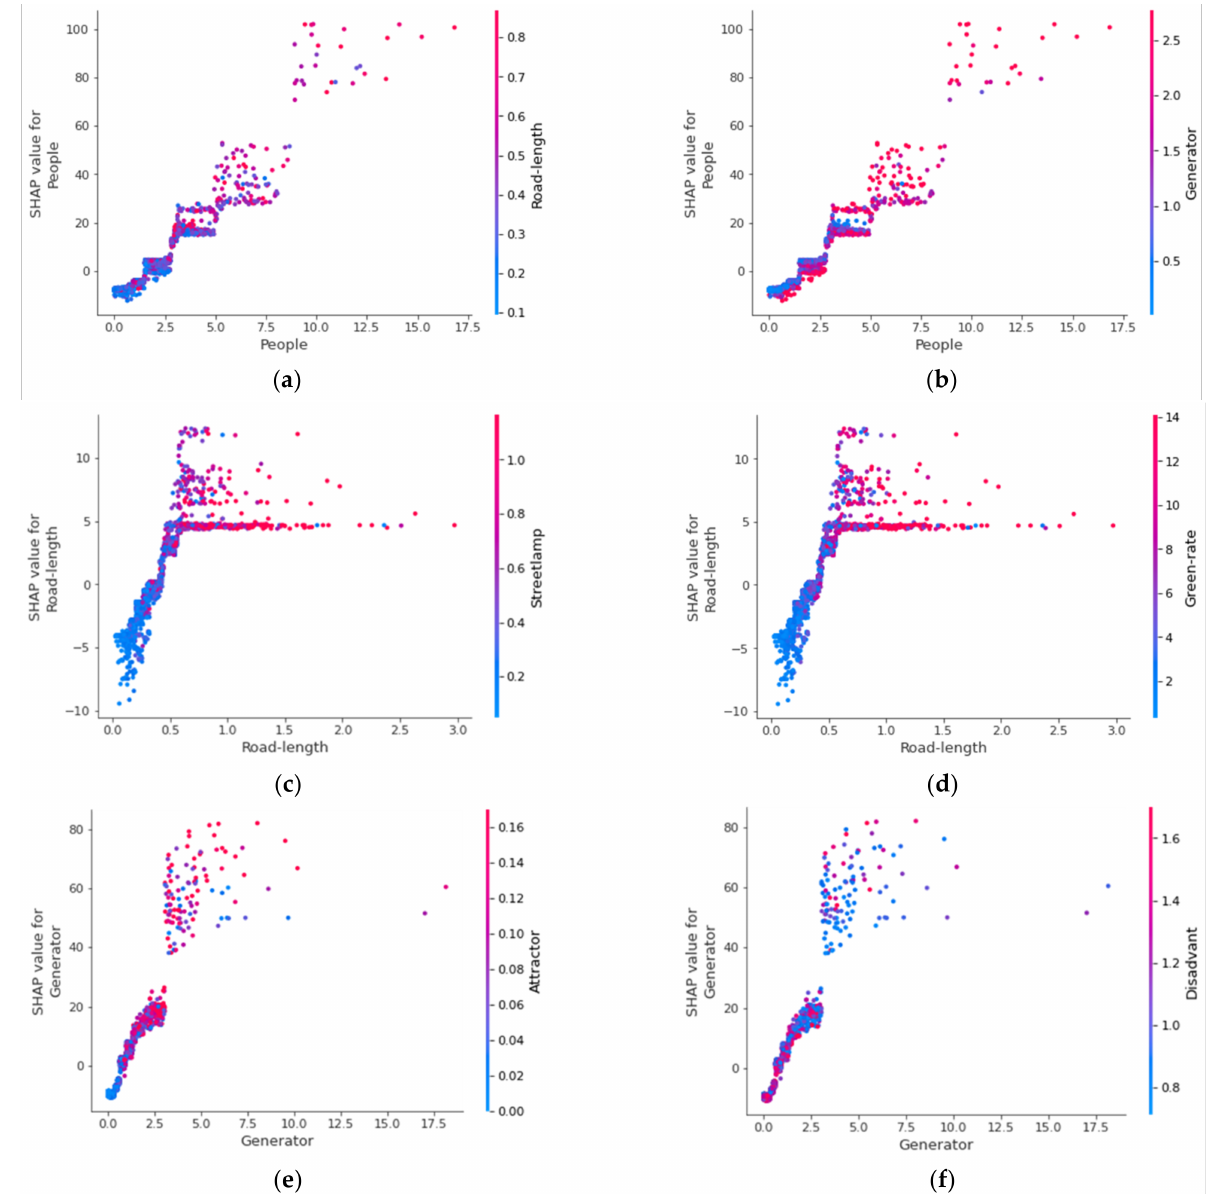
Figure 10. The interaction effect between different variables. ( a ) the number of people on the street and the length of the street segment, ( b ) the number of people on the street and crime generators, ( c ) the length of the street segment and the number of street lights, ( d ) the length of the street segment and the green rate, ( e ) the number of crime generators and crime attractors, ( f ) the number of crime generators and the community socioeconomical